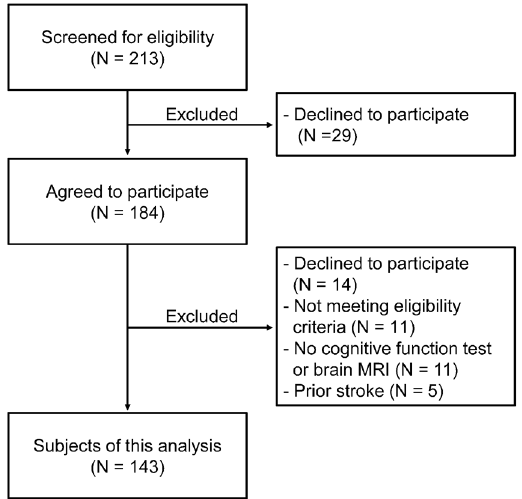
Figure 2. Selection of the participants. We excluded 5 participants because of the presence of prior stroke which was clinically symptomatic and diagnosed by imaging